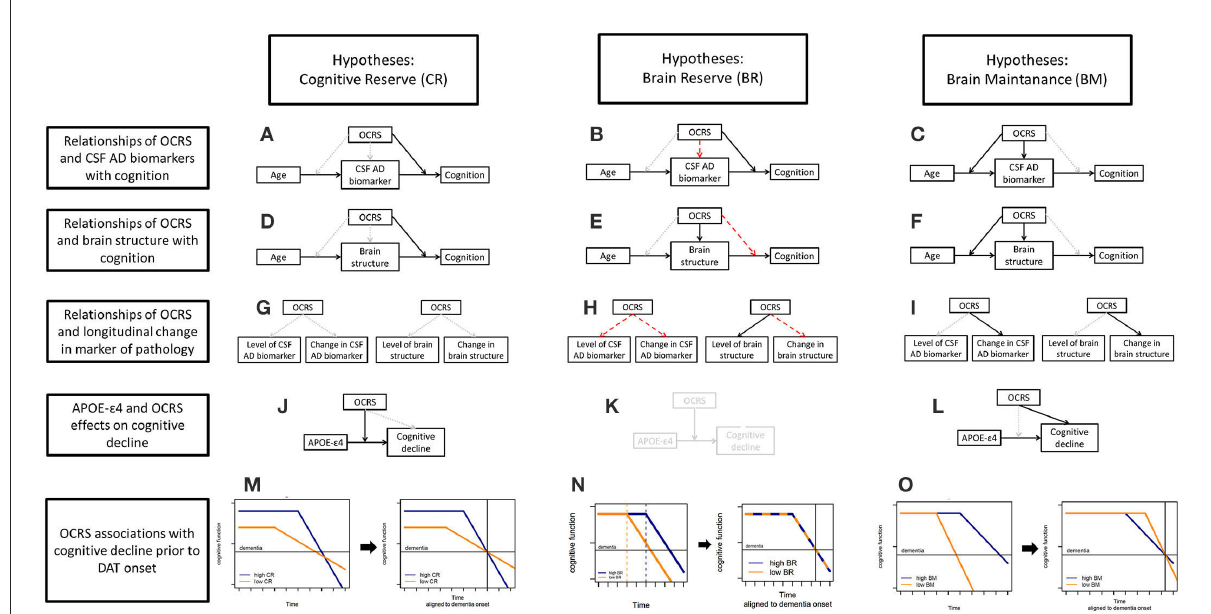
FIGURE1 (A) Hypotheses for CR regarding the relationship of the OCRS and CSF AD biomarkers with cognition. (B) Hypotheses for BR regarding the relationship of the OCRS and CSF AD biomarkers with cognition. (C) Hypotheses for BM regarding the relationship of the OCRS and